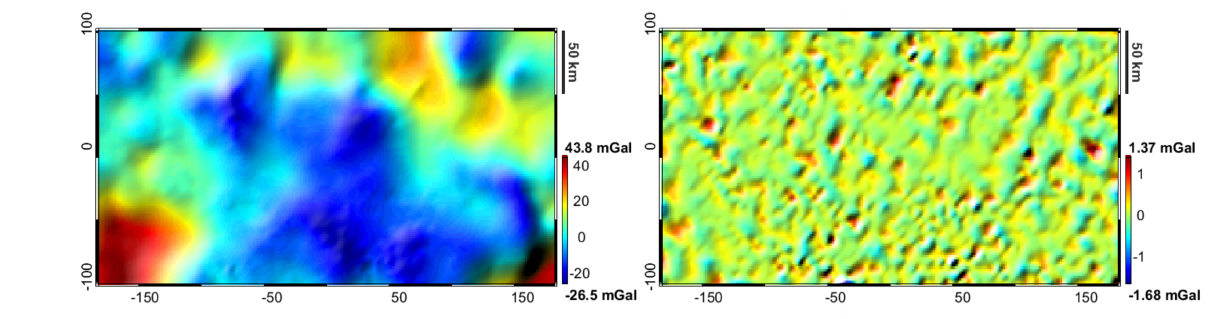
Figure 11. Scenario 2 inversion: Difference between the gravitational effect of the true and a priori model ( left ) and of the true and the a posteriori model ( right ).